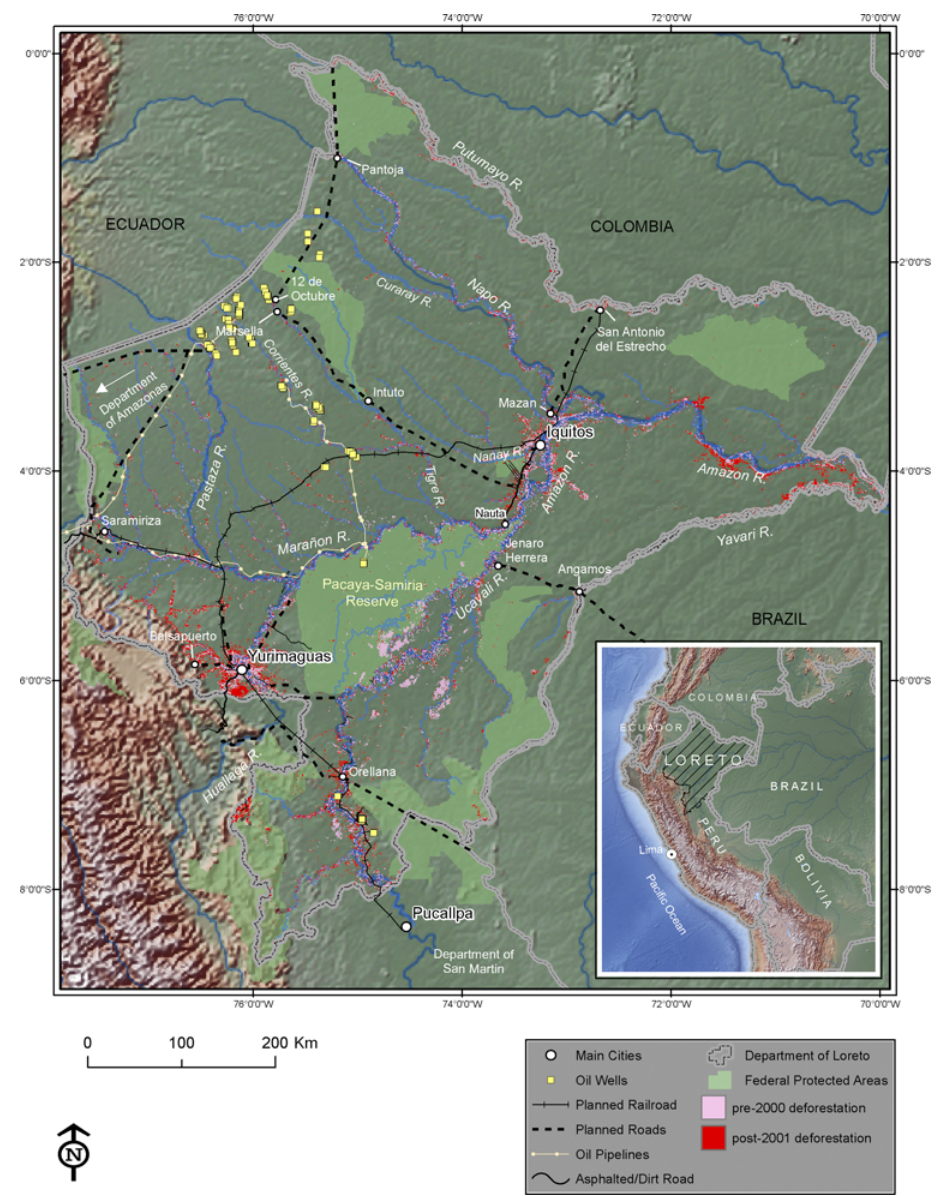
Fig 1. Department of Loreto in the Peruvian Amazon. Planned infrastructure will crisscross the department and will provide connection to the national road